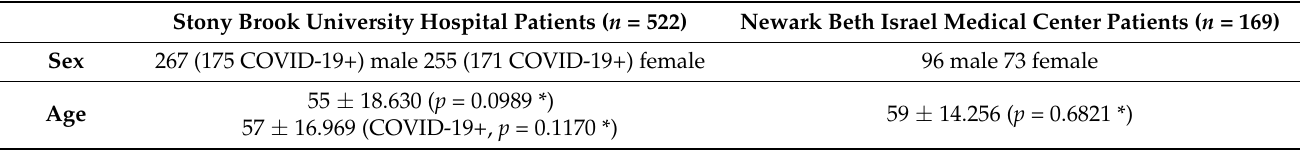
Figure 2. Summary of patient inclusion and exclusion criteria: ( a ) displays criteria for SBUH and ( b ) displays criteria for NBIMC. Ineligibility criteria included pediatric patients, existing intubation status prior to CXR acquisition, poor image orientation, or indistinguishable lung fields on CXR. Table 1. Total patient demographics table.